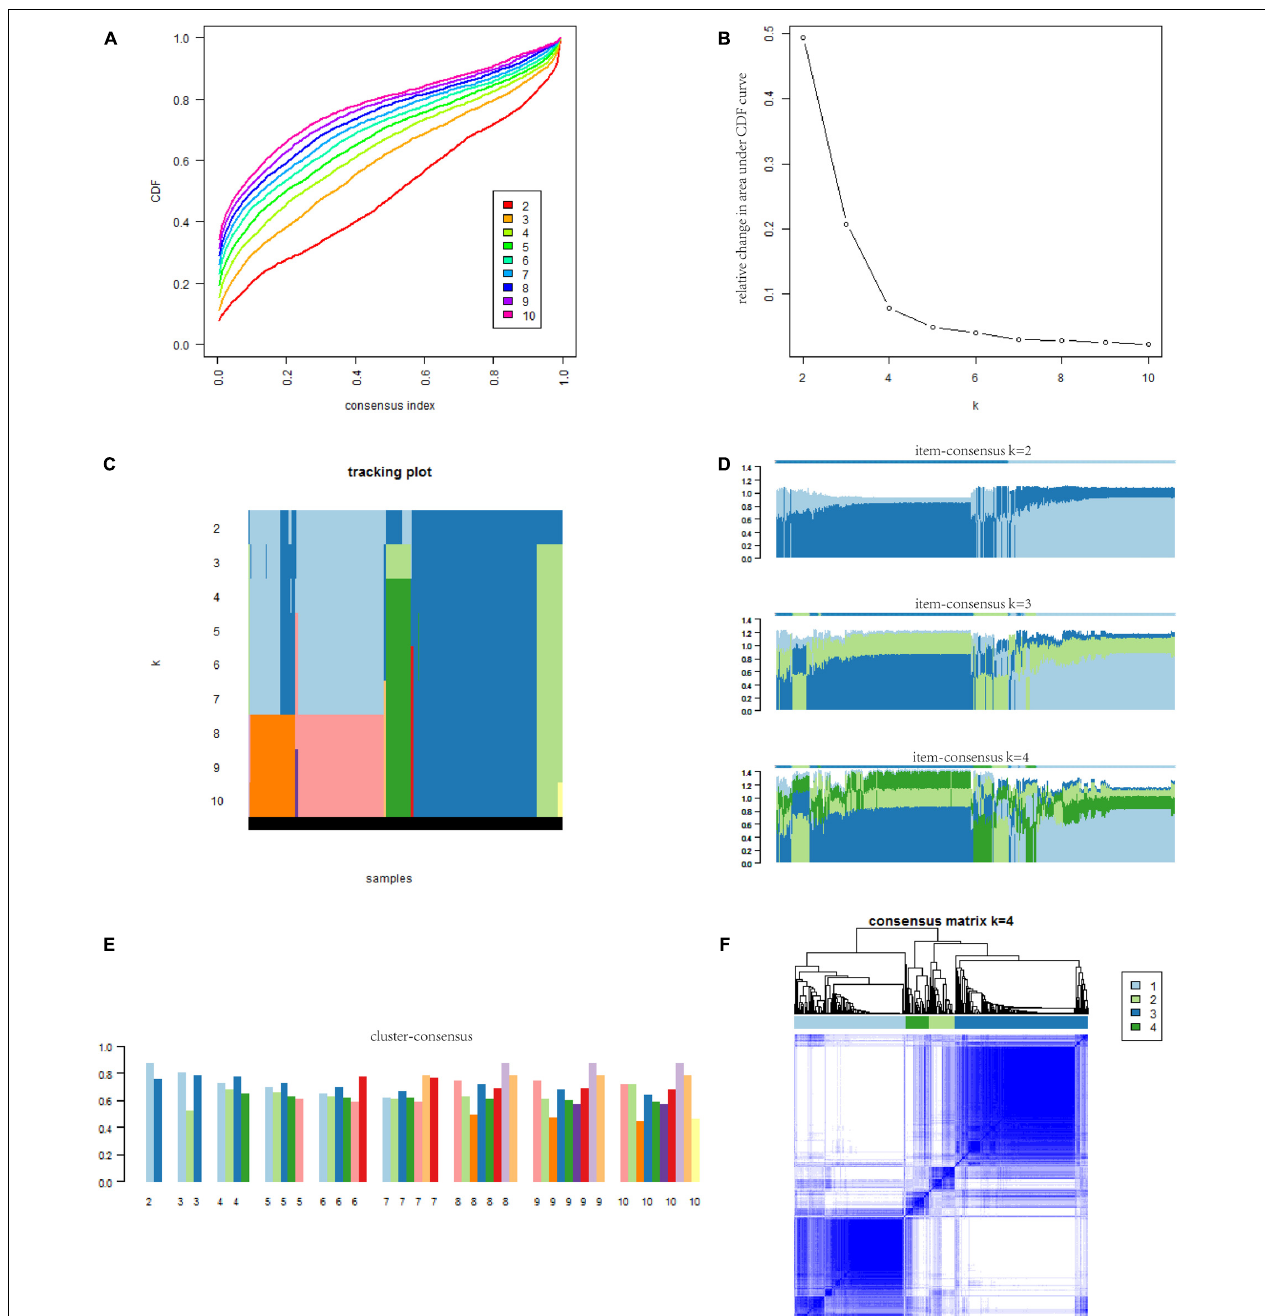
FIGURE 1 | The results of consensus cluster for PCa patients. (A) The CDF curve under different values of k . The value of k represents the number of clusters during the consensus cluster. When the optimal k value is reached, the area under the CDF curve will not significantly increase with the increase of k value. (B) Relative change in area under the CDF curve under different values of k . (C) The x -coordinate of the graph is items, and the y -coordinate is the value of k . Each color corresponds to different cluster classification colors in the consensus cluster. If items always change the type of cluster (i.e., change the color in a column), it indicates an unstable classification relationship. If a cluster has a large number of samples with unstable classification, it indicates that the cluster is not a stable classification and cannot become a subtyping. (D) The figure reflects the item-consensus of each patient for different clusters. The item-consensus reflects the degree of representation of an individual to different clusters. The greater the value, the more representative the individual is of the characteristics of the corresponding cluster. (E) The diagram shows the cluster-consensus for each cluster with different k values. The cluster-consensus refers to the average value of the consensus matrix of each cluster and represents the degree of consensus of this cluster. The higher the cluster-consensus of the cluster, the higher the stability of this cluster. (F) The consensus matrix obtained when k = 4. Consistency values range from 0 to 1, 0 means never clustering together (white) and 1 means always clustering together (dark blue). PCa, prostate cancer; CDF, cumulative distribution